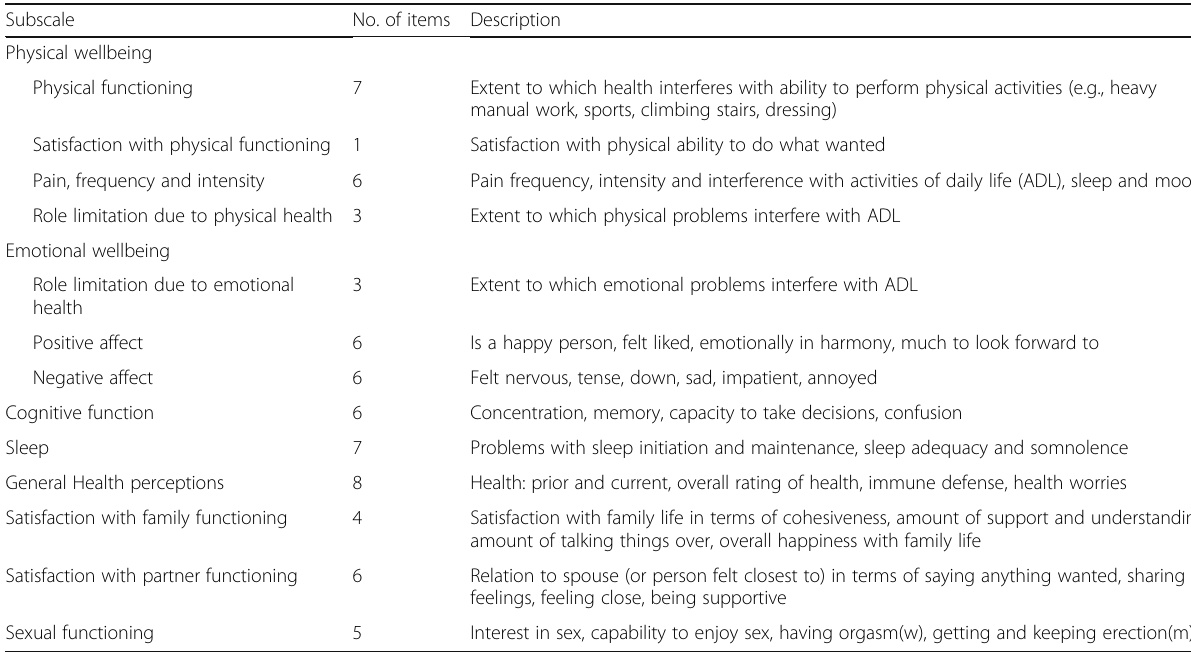
Table 4 Characteristics of subscales in SWED-QUAL